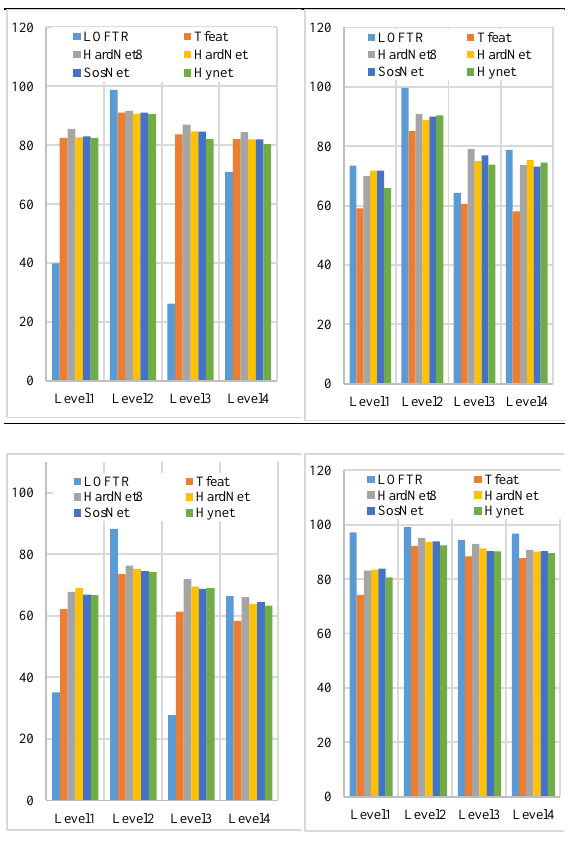
Figure 7. The precision values for the scale test, the first row from left to right relates to cases a and b, and the second row from left to right relate to cases c and d, respectively.